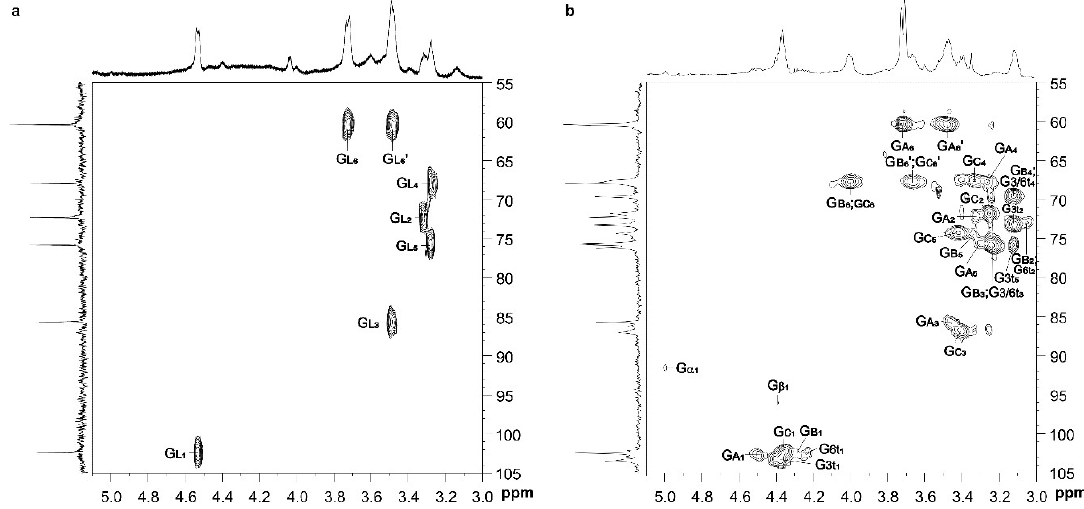
Figure 3. 13 C NMR spectra (100.63 MHz, Me 2 SO- d 6 , 70 ◦ C) of GW-p ( a ) and GW-s ( b ).